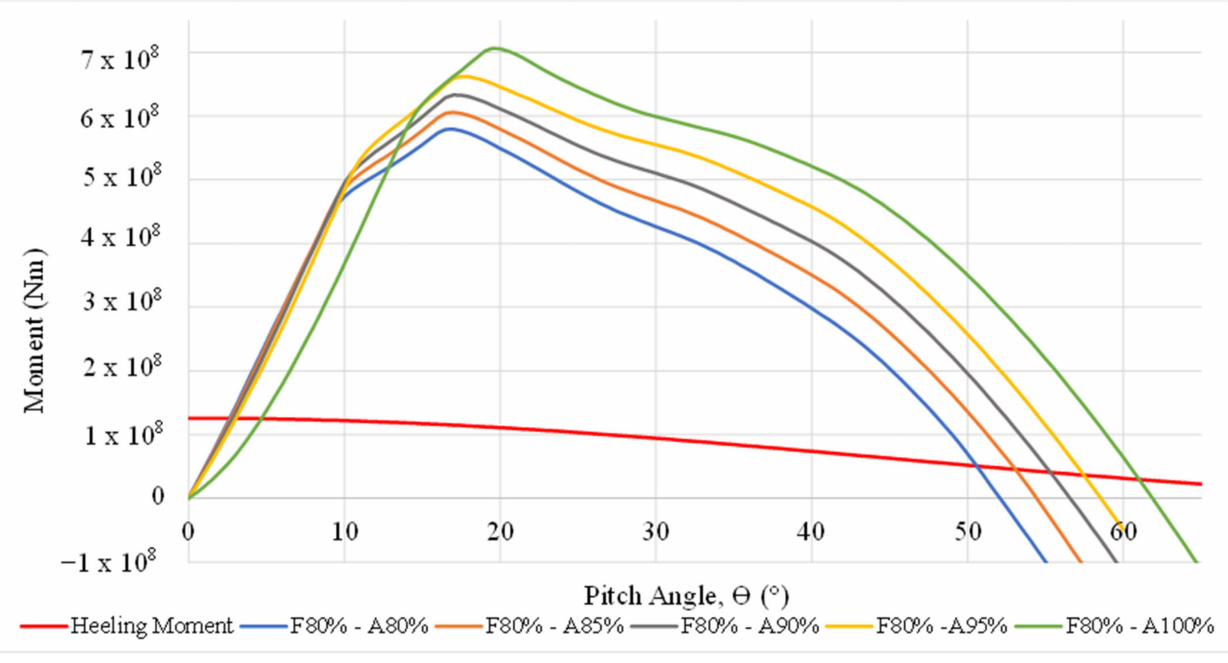
Figure 14. SA: PB—Righting moment and wind heeling moment curves. The results of SA: PB with respect to the DNV ST-0119 standards can be found